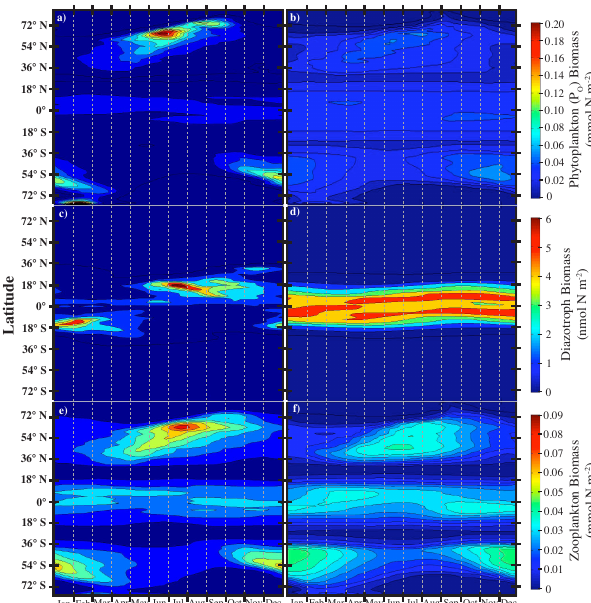
Fig. 17. Hovm¨oller diagrams of the zonally averaged seasonal inte- grated phytoplankton (a, b) , diazotroph (c, d) and zooplankton (e, f) biomasses as simulated by the new (left panels) and old (right panels) models.